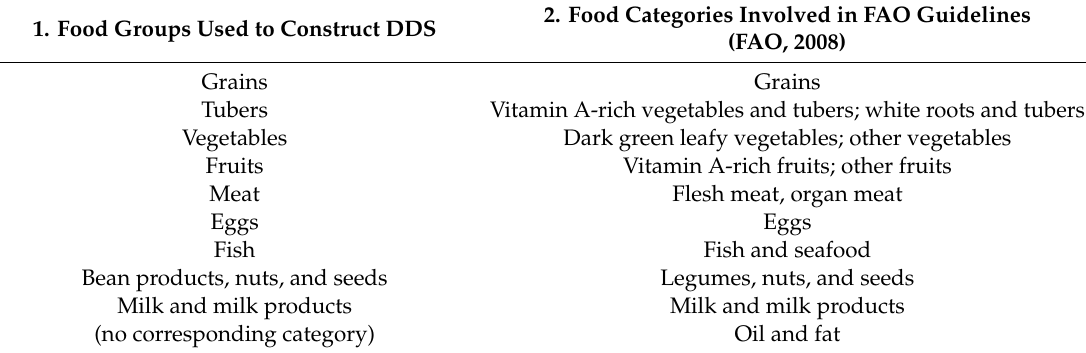
Table 2. Comparisons of food categories involved in definitions of Dietary Diversity Score